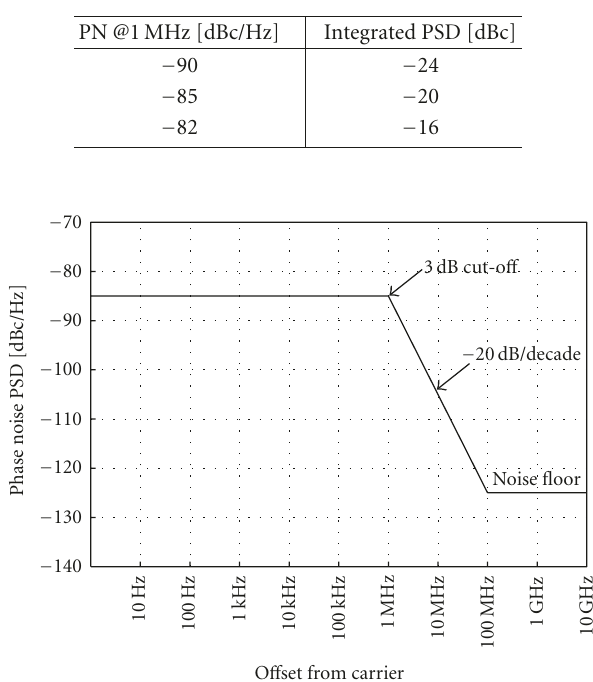
Table 2: Simulated integrated PSD.